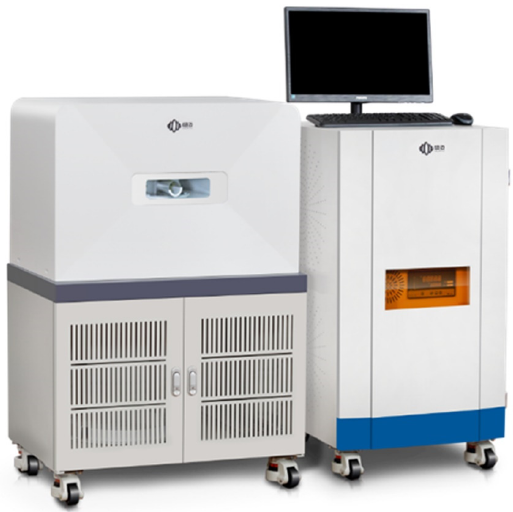
Figure 3. MesoMR23-060H-I instrument for LF-NMR experiments.